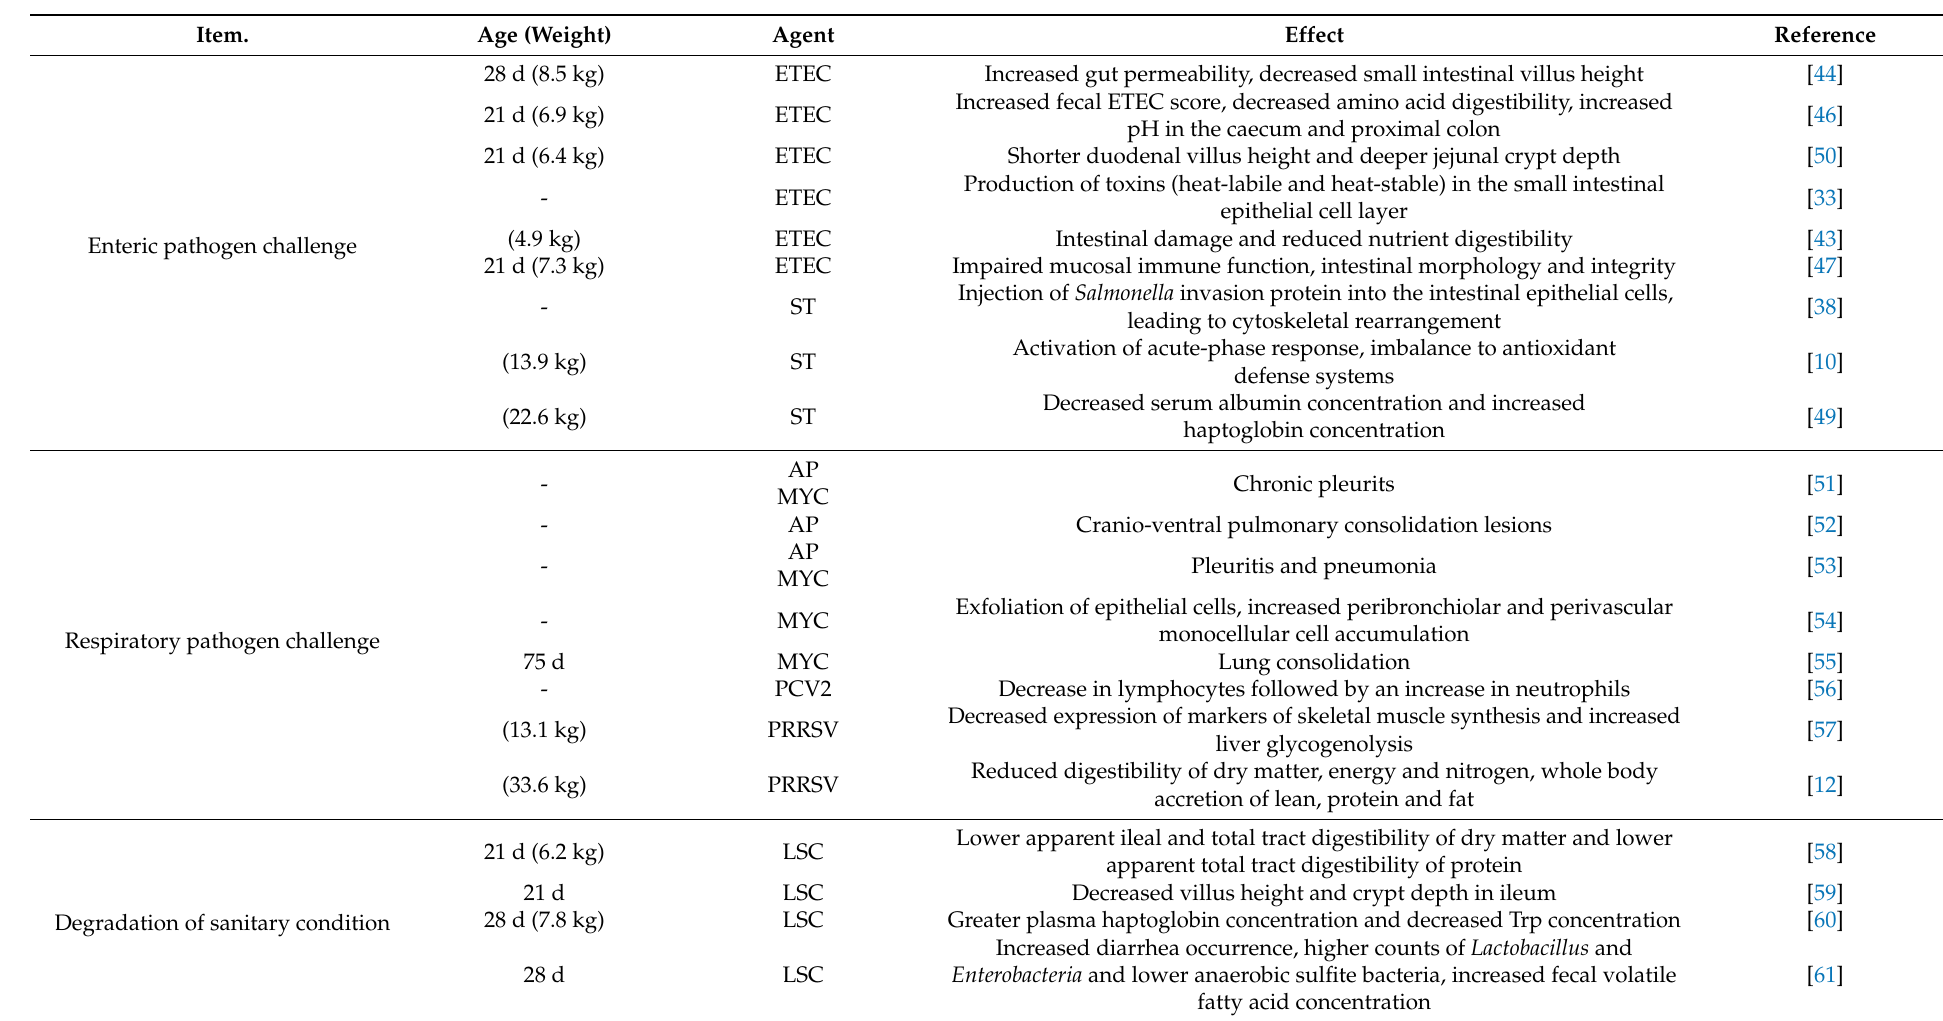
Table 1. Mechanisms through which challenge models impact nutrient digestion and metabolism and growth performance.